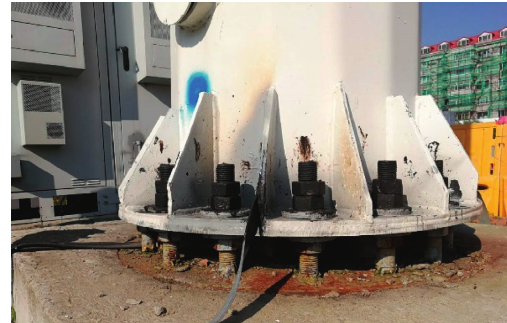
Figure 2: Photograph of the high-strength bolts of the junction.